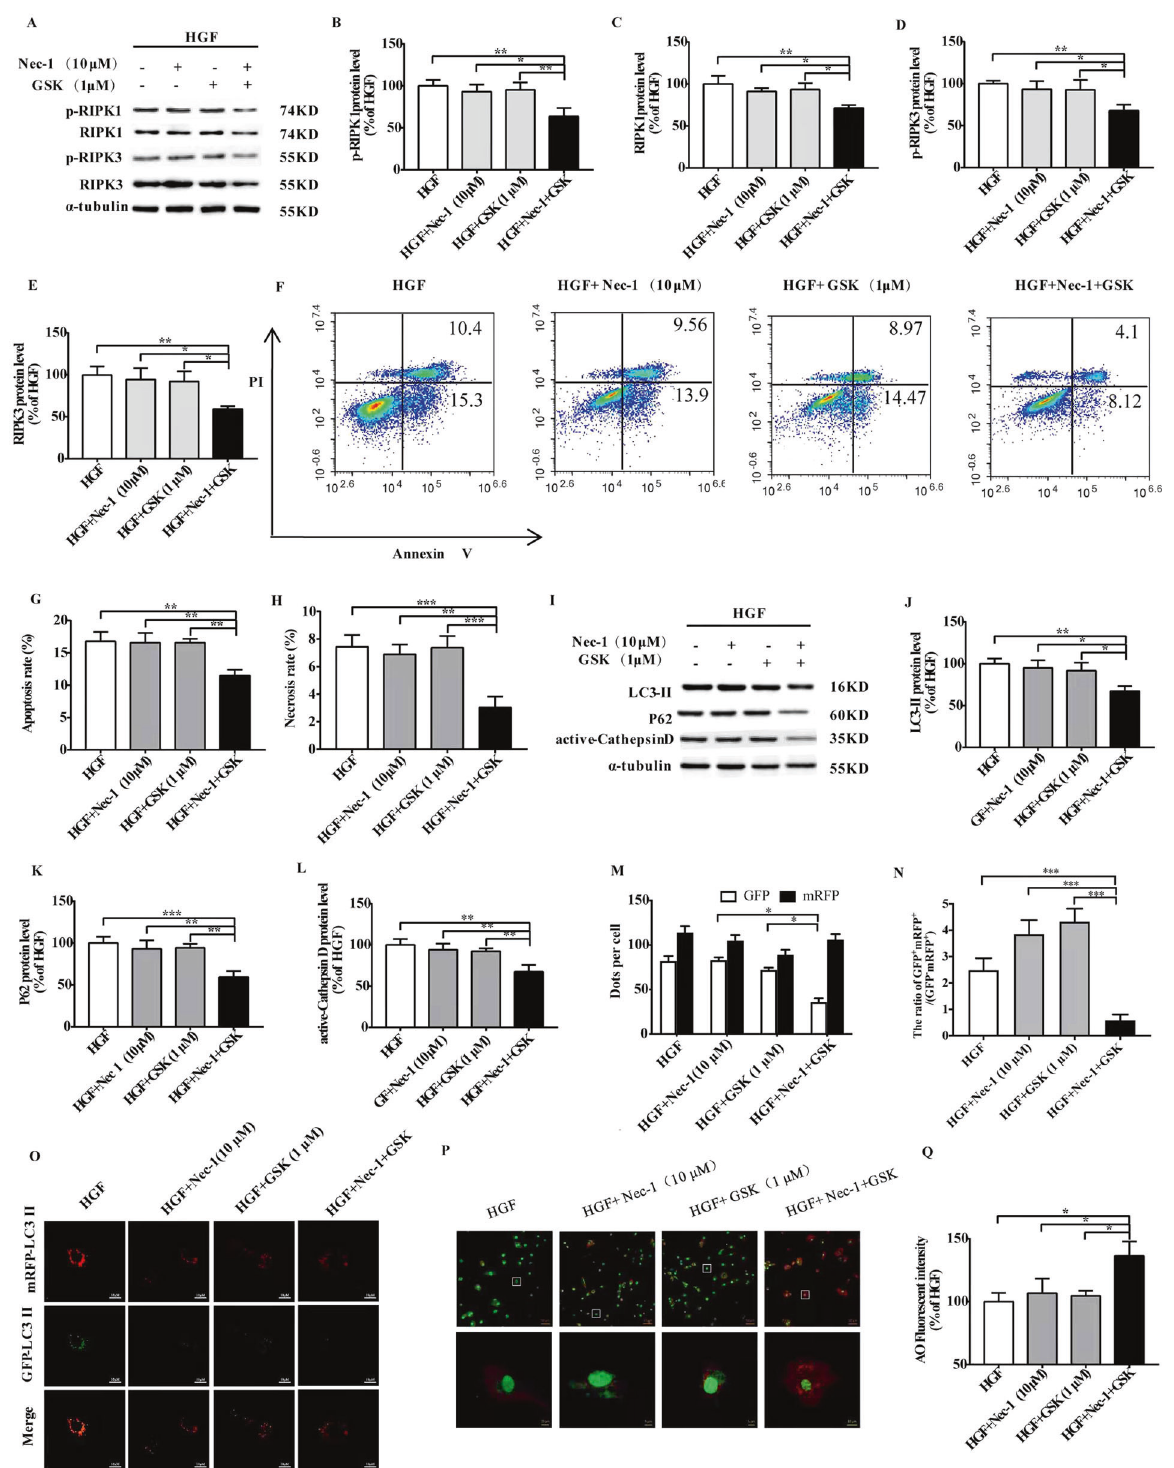
Fig. 5 The combination of low-dose RIPK1 and RIPK3 inhibitors alleviates cell death and restores autophagic fl ux. Combination of Nec-1 (10 μ M) and GSK (1 μ M) down-regulates the levels of RIPK1, ser166-p-RIPK1, RIPK3, ser232-p-RIPK3, alleviates cell death and restores autophagic fl ux of CFs. Representative images and percentages of RIPK1, ser166-p-RIPK1, RIPK3, ser232-p-RIPK3 ( A – E ); fl ow cytometry analysis results ( F – H ); Confocal images and the ratio of GFP + mRFP + /(GFP - mRFP + ) and AO fl uorescence intensity ( I – M ); Representative images and percentages of LC3-II, P62, active-cathepsin D ( N – Q ); n = 3 per group. Means ± SD. * P < 0.05, ** P < 0.01, *** P < 0.001. NGF normal glucose and fat group, HGF high glucose and high fat group, Nec-1 necrostatin-1, GSK GSK872, AO acridine orange.